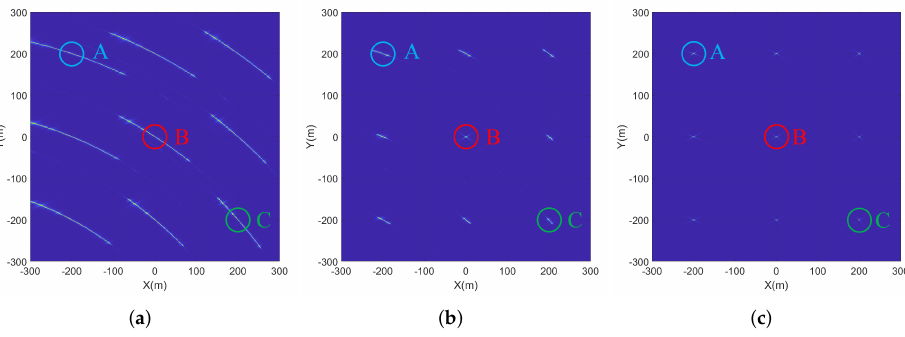
Figure 12. Simulation results: ( a ) image without motion error compensation; ( b ) image with conven- tional autofocus [25]; ( c ) image with the trajectories estimated by the proposed